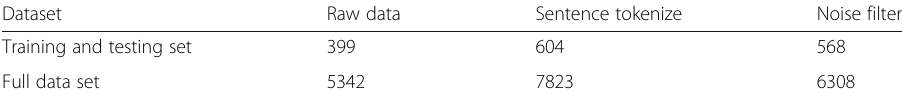
Table 4 Datasets for training and